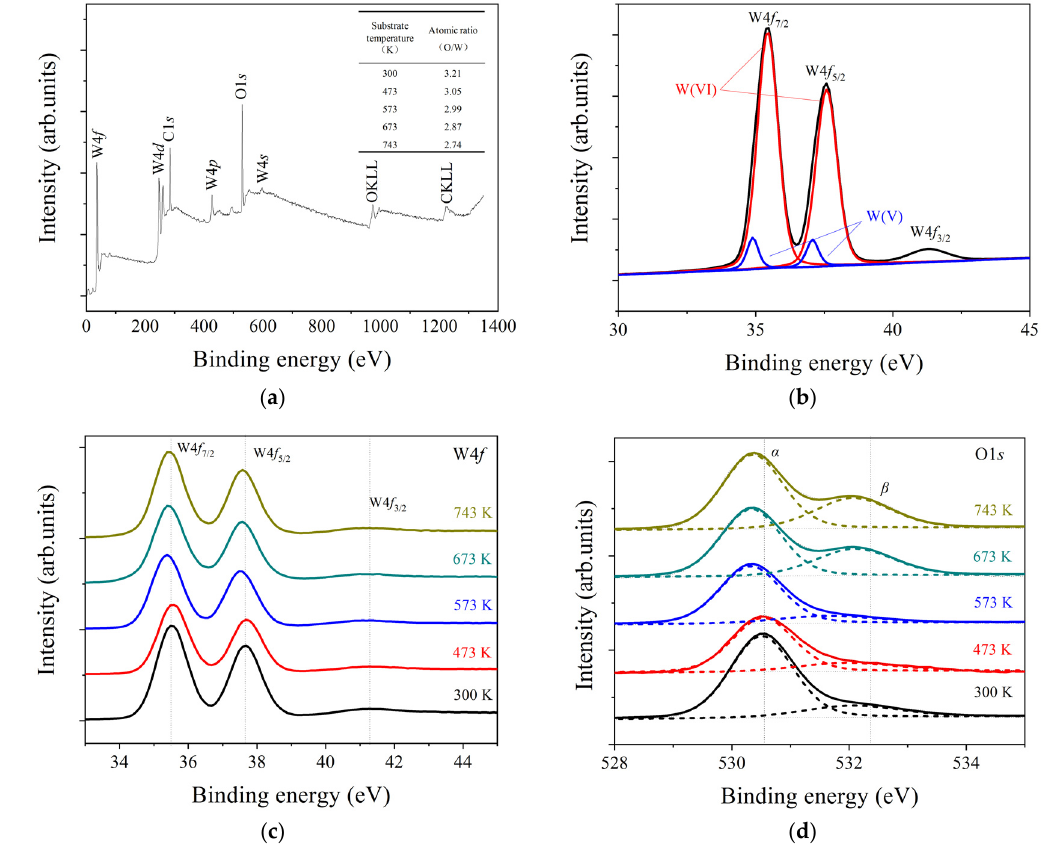
Figure 2. The WO 3 thin films deposited at different substrate temperatures: ( a ) X-ray photoelectron spectroscopy (XPS) full spectra, ( b ) W4 f Gaussian fitting peak spectra, ( c ) W4 f spin orbit energy level spectra and ( d ) O1 s spin orbit energy level spectra.